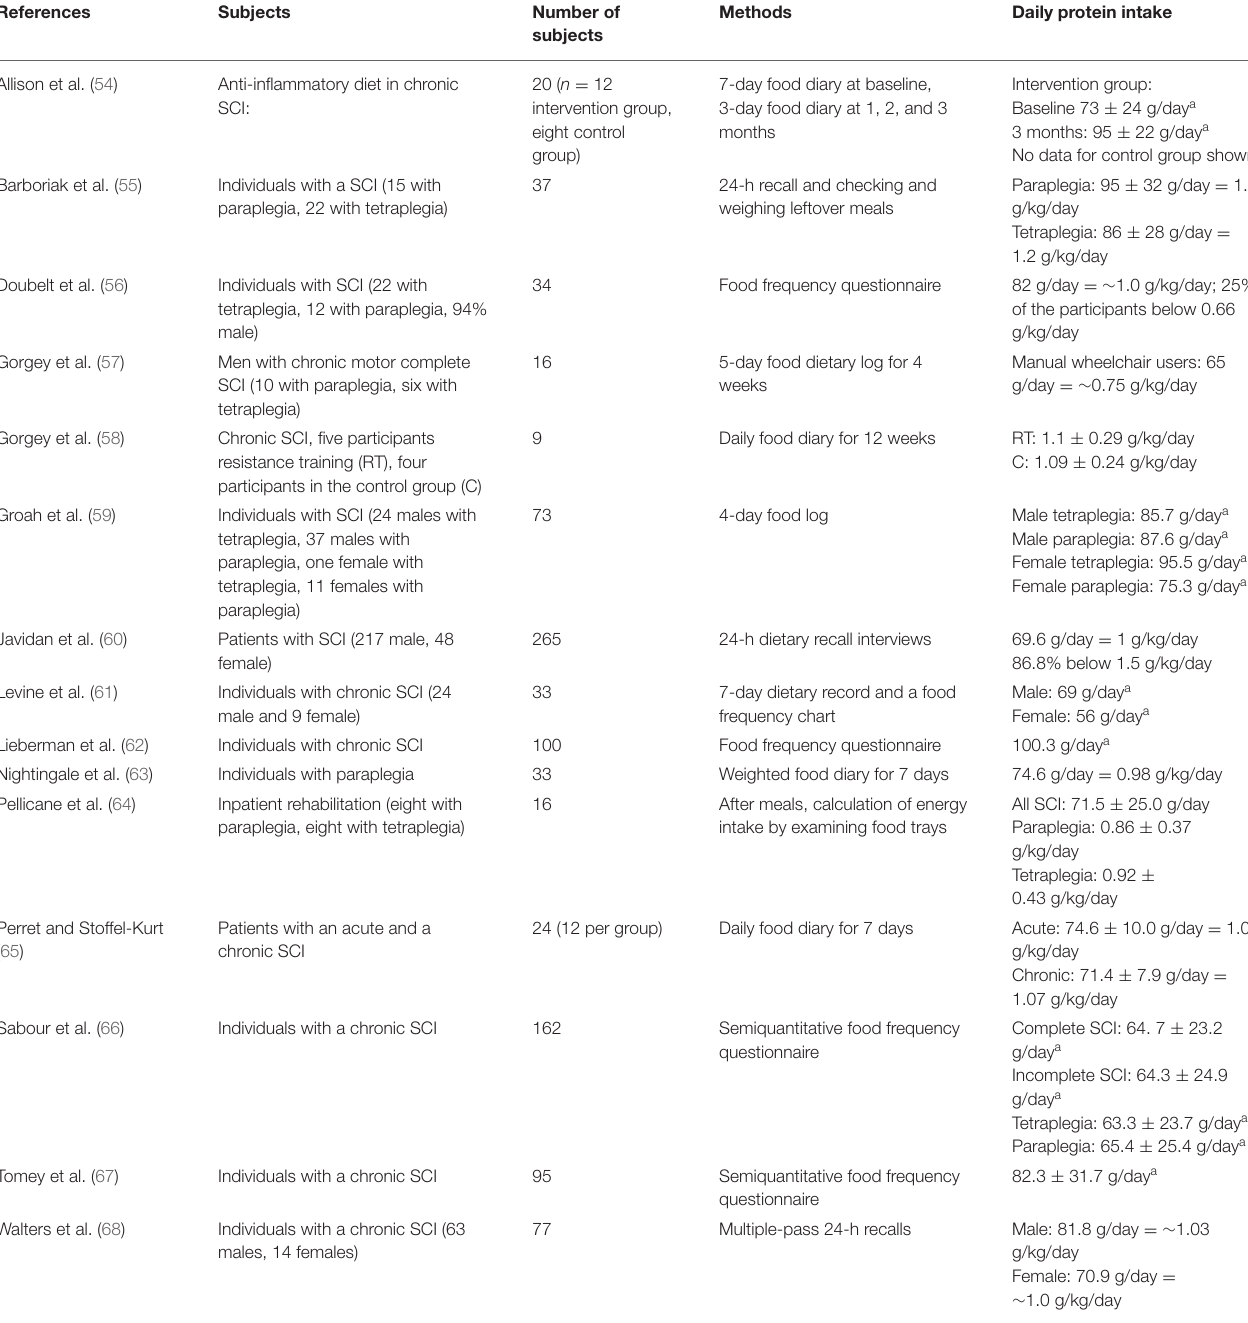
TABLE 1 | Protein intake in individuals with chronic SCI (non-athletes).